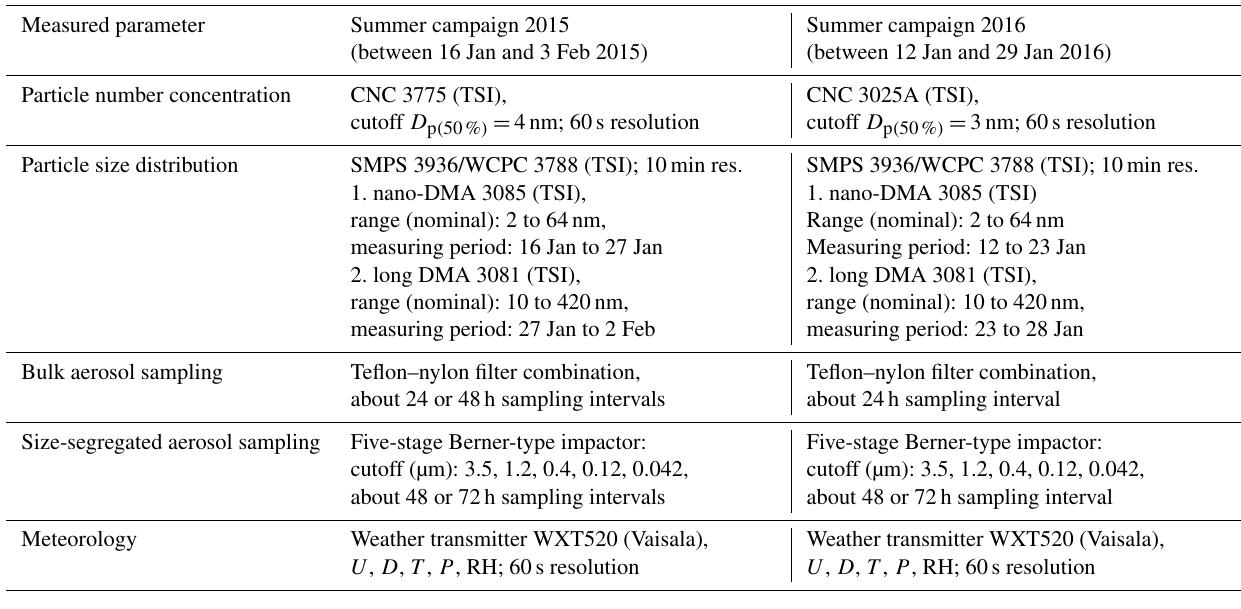
Table 1. Survey of the experimental setup during both summer campaigns at Kohnen station. Measured parameter